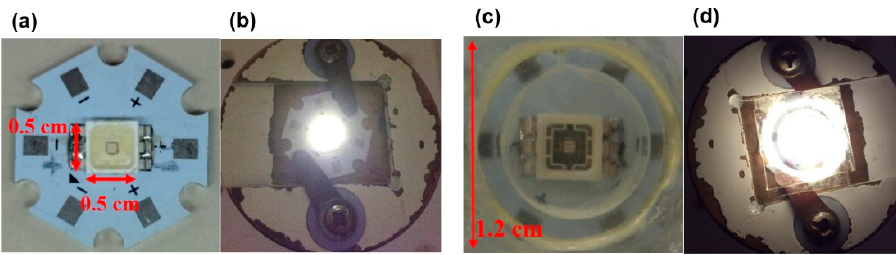
Figure 5. Photograph of ( a ) RWQD-WLED before UV excitation, ( b ) RWQD-WLED under UV-LED excitation, ( c ) LWQD-WLED before UV-LED excitation, ( d ) LWQD-WLED under UV-LED excitation.